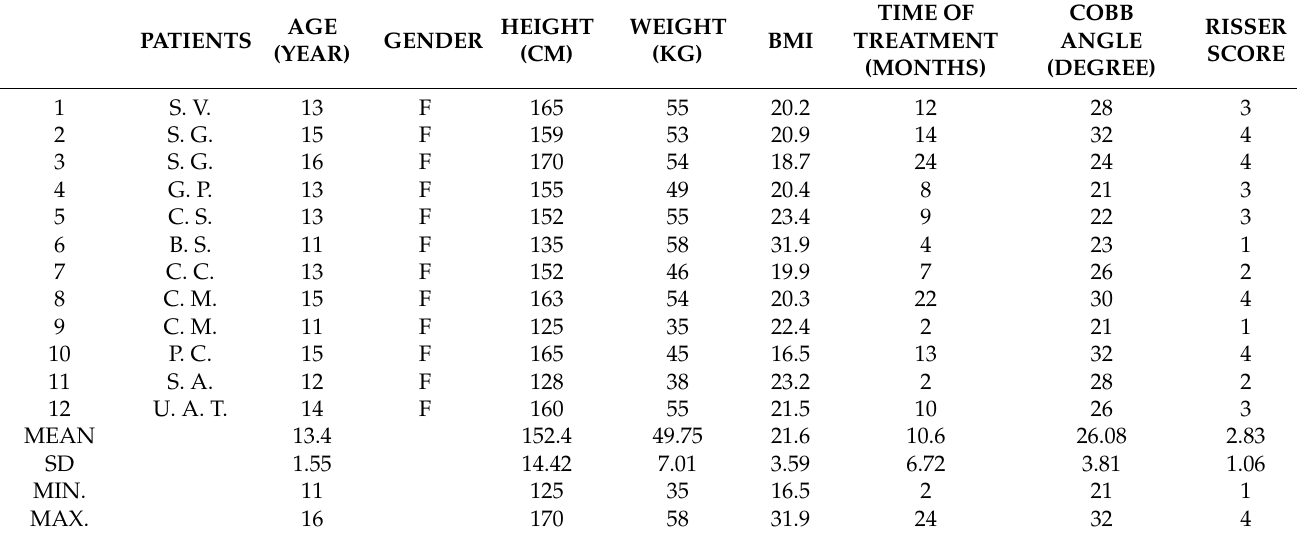
Table 2. Patients’ vital characteristics: Demographic and clinical data.